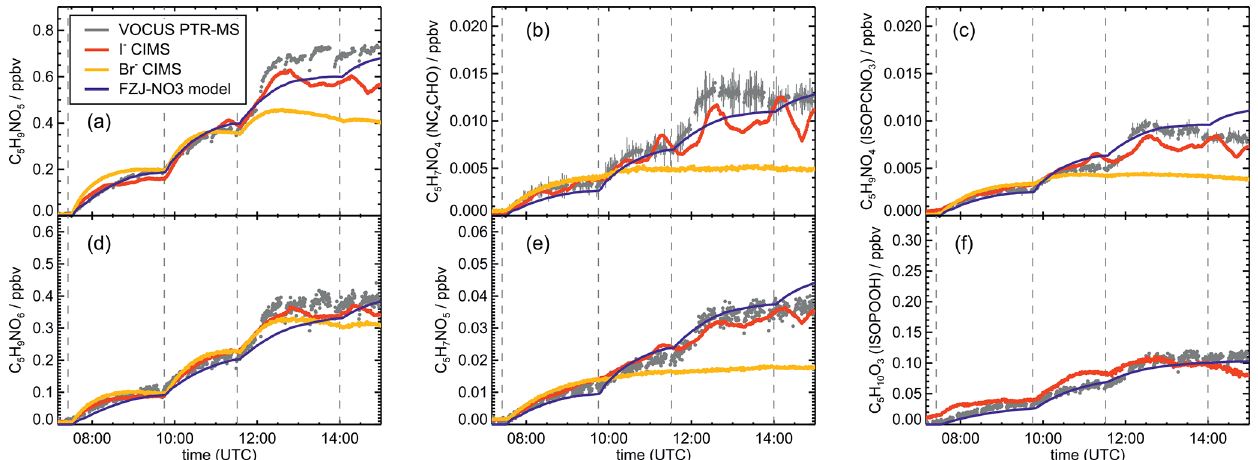
Figure A7. Comparison of reported signals from three mass spectrometer instruments applying different ionization methods (Vocus PTR- MS, Br − CIMS, I − CIMS) and measuring organic products in the experiment on 9 August 2018 (Experiment 1). All signals are scaled to match best the concentrations resulting from model calculations applying the FZJ-NO3 chemical